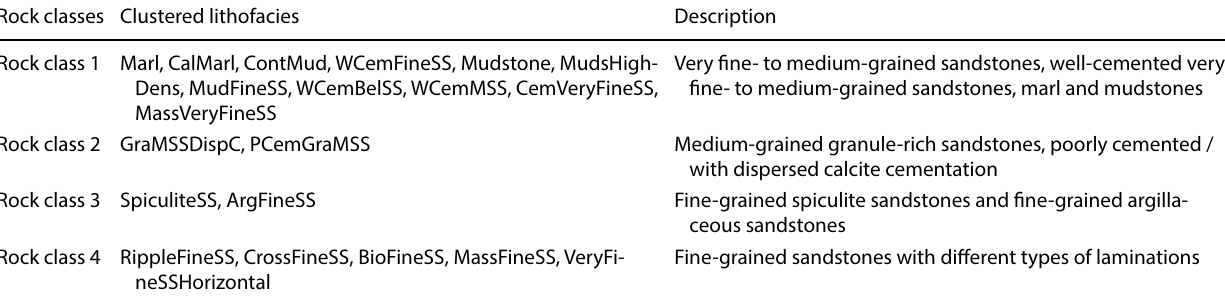
Table 6 Proposed rock classes resulted from merging similar lithofacies classes Rock classes Clustered lithofacies